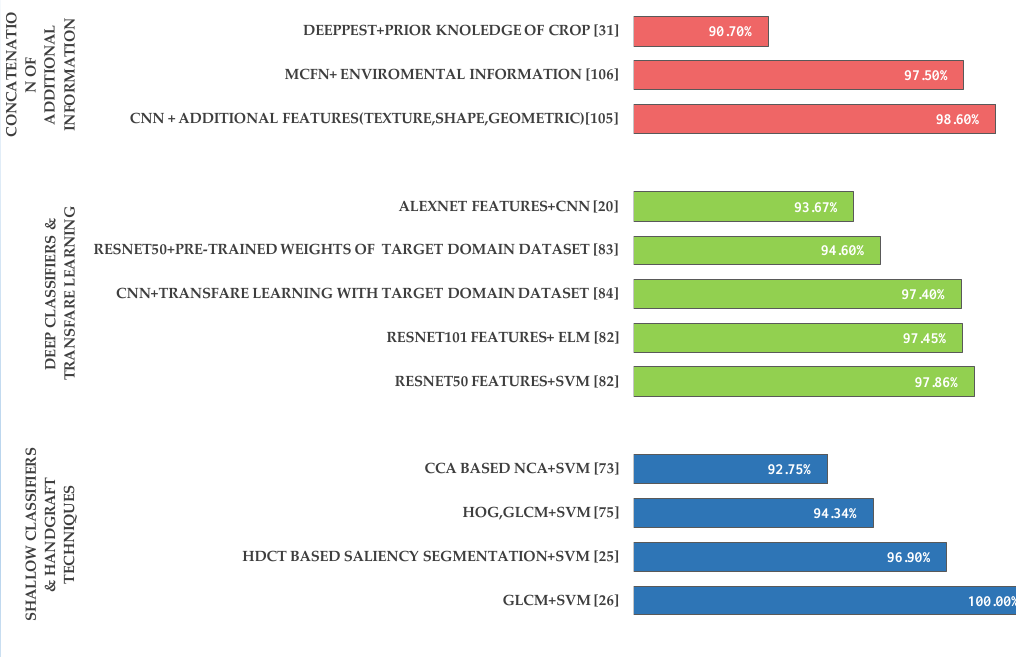
Figure 6. Highest accuracy levels achieved using different techniques.